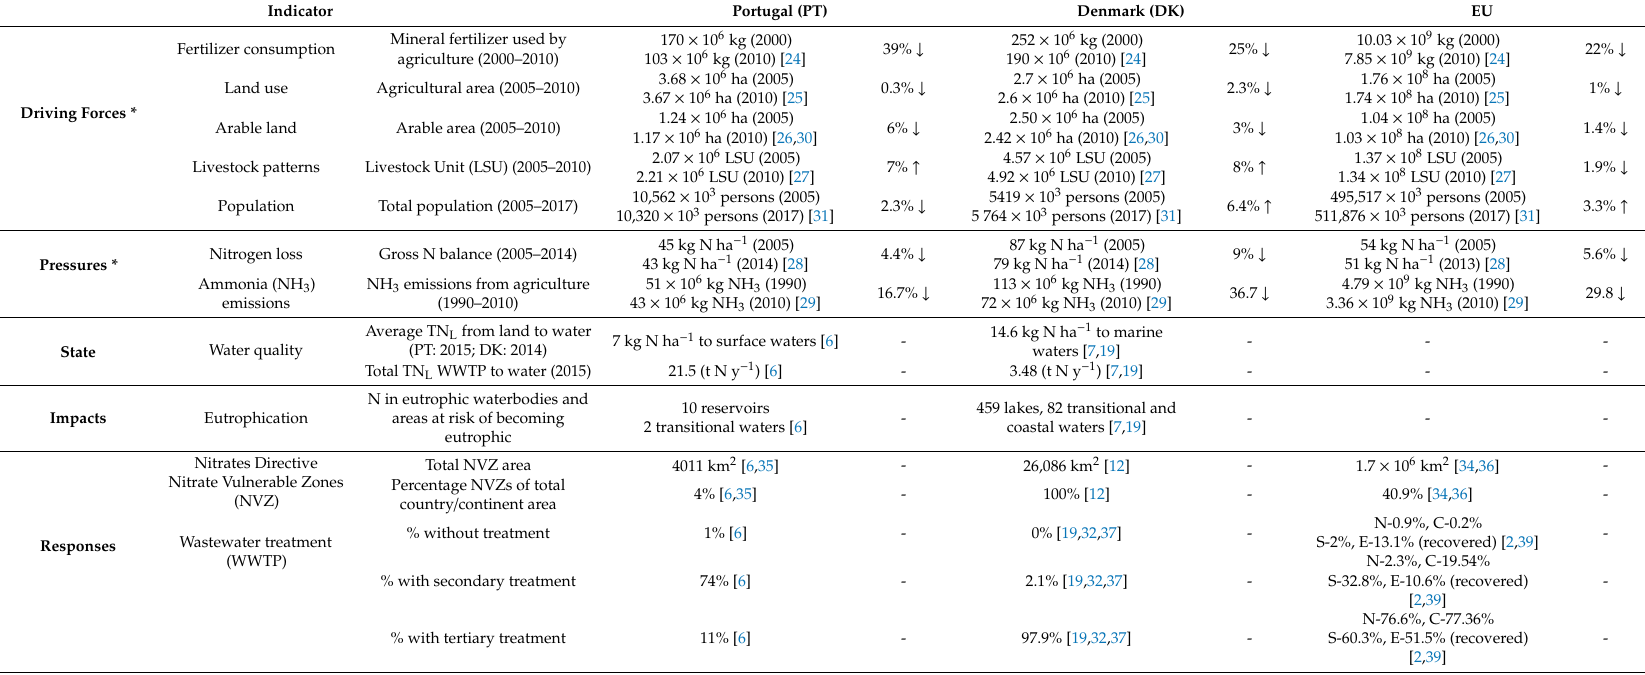
*Arrows in Driving forces and Pressures indicate the tendency for a specific indicator to increase ↑ or decrease ↓ between the years into